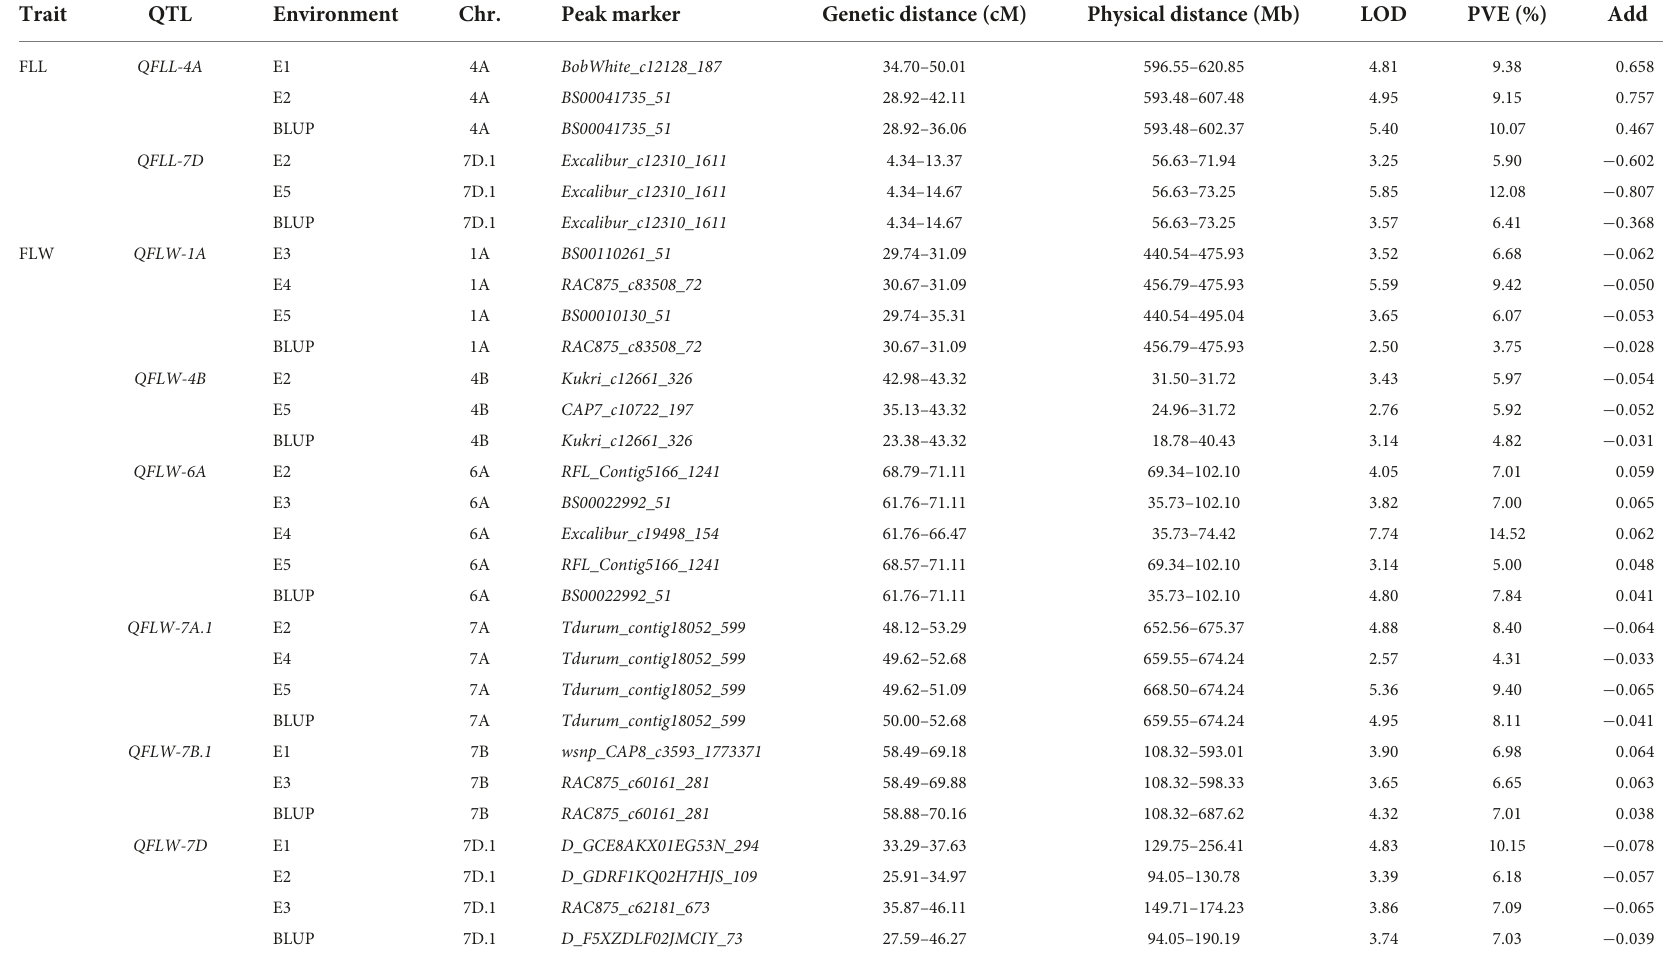
TABLE 4 Stable quantitative trait loci (QTL) for flag-leaf-related traits detected in the DH population derived from Jinchun 7 × Jinmai 919.